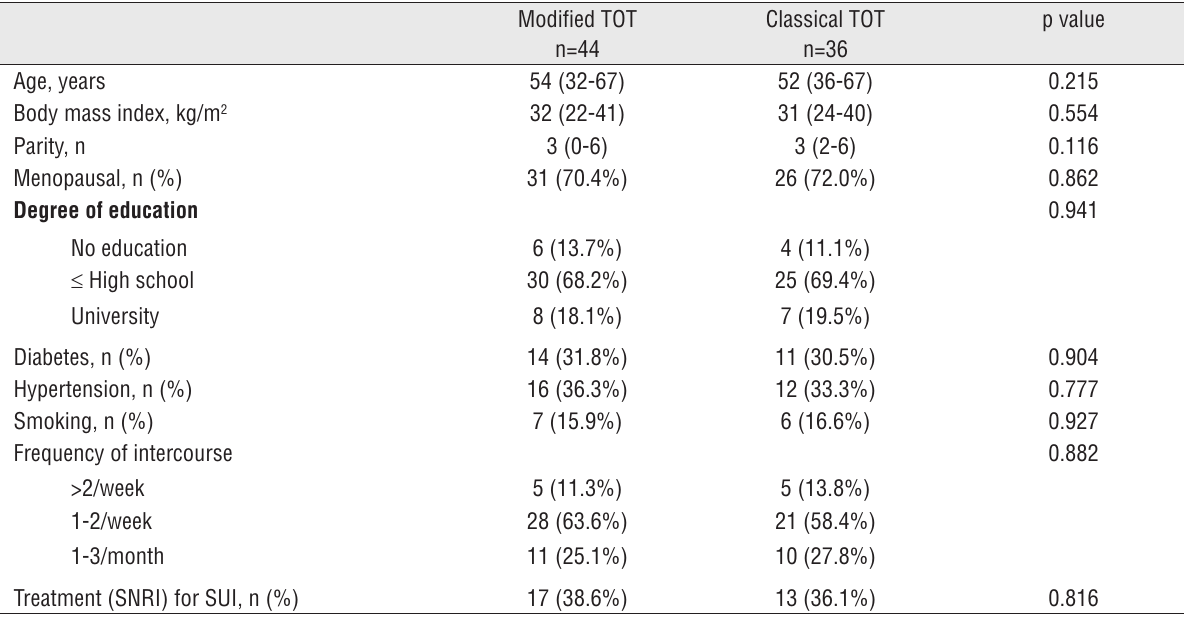
Table 1 - Comparison of baseline characteristics of